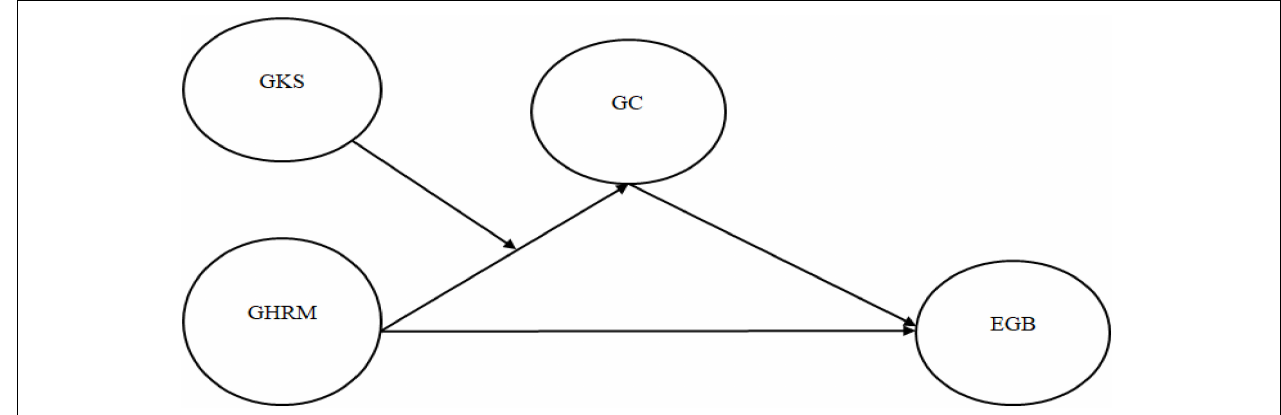
FIGURE 1 | Research model. GKS, green knowledge sharing; GHRM, green human resource management; GC, green commitment; and EGB, employee green behavior. TABLE 5 | Path coefficient.